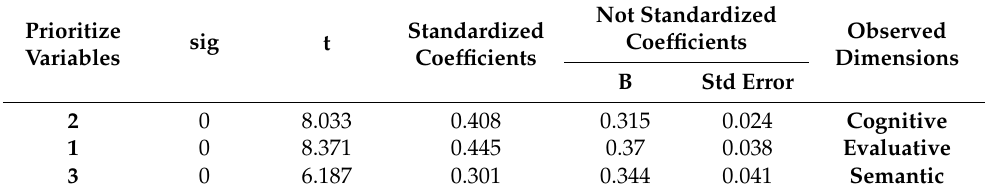
Table 8. Beta coefficients of the criteria constituting the overall perception (Source: Authors). Prioritize